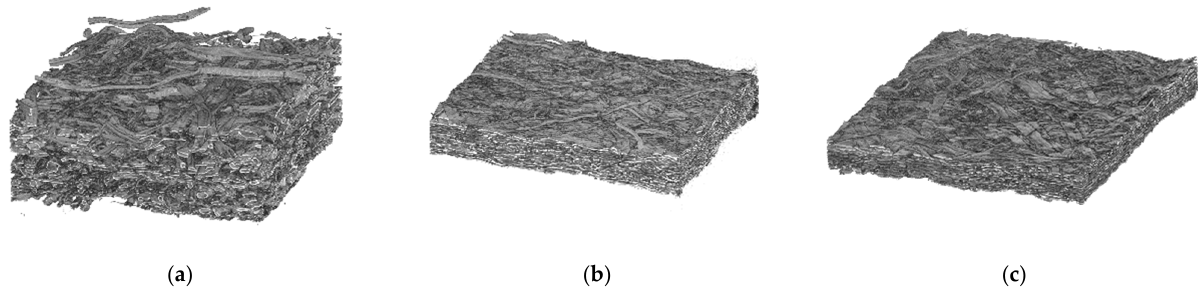
Figure 4. 3D visualisations of the CT images of samples. ( a ) Unpressed reference, ( b ) pressed at 190 °C, and ( c ) pressed at 270 °C. Table 1. Effective density of the TMP sheets obtained from the X-ray microtomography (CT) com- pared with the standard measurement.